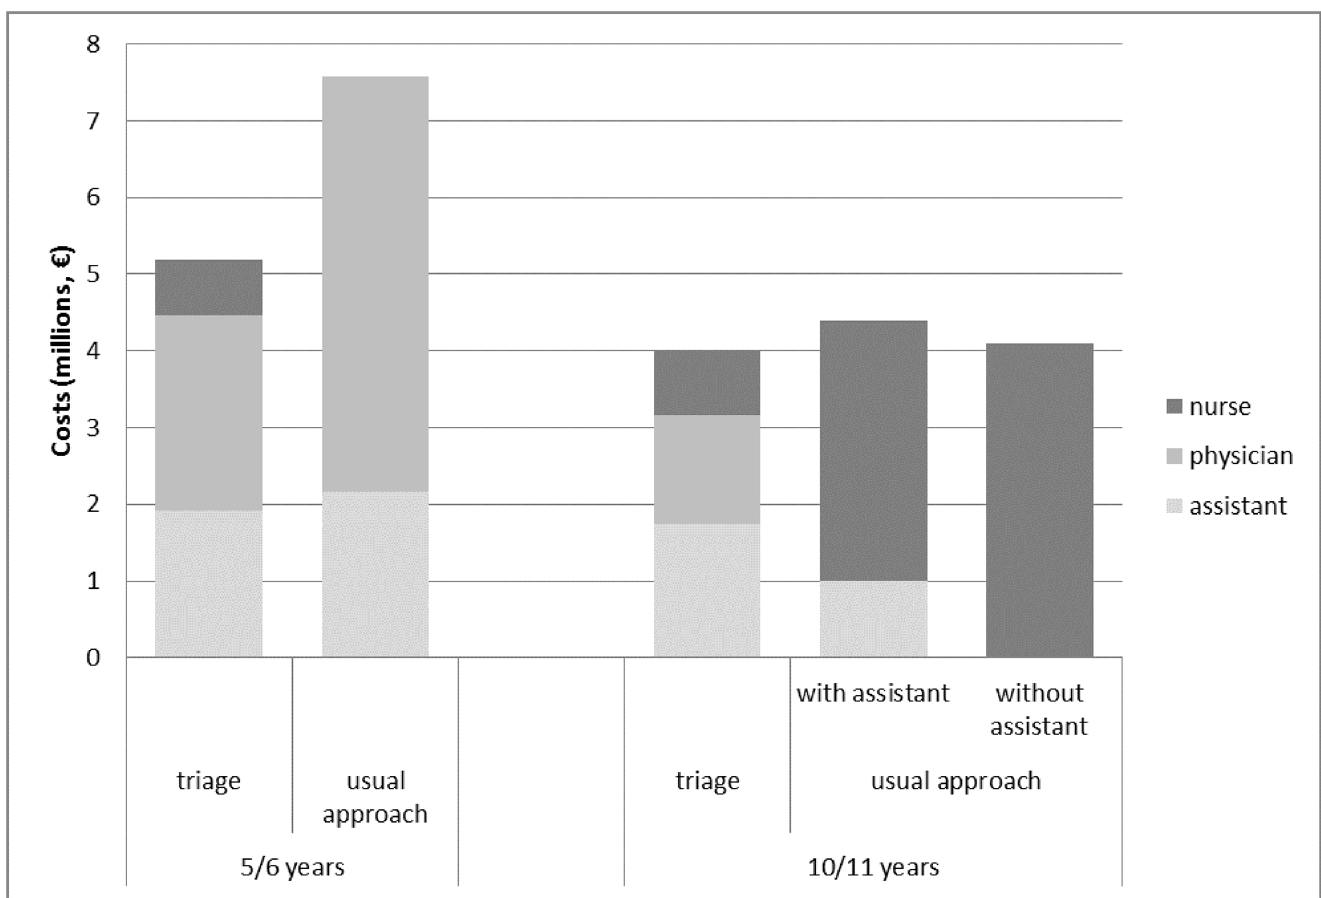
Fig 3. Projected costs (2013 € ) of the deployment of professionals for routine health assessmentsof children aged 5/6 and 10/11 years, triage and usual approaches.